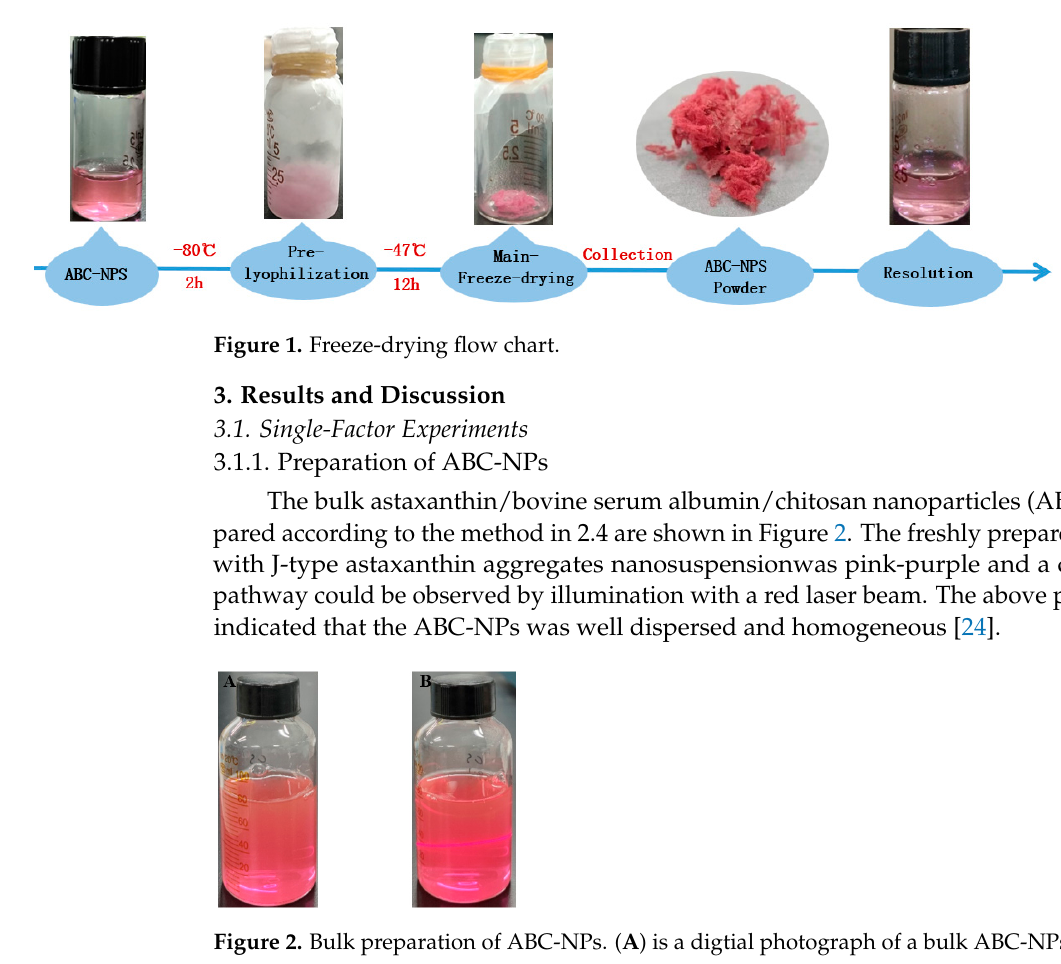
Figure 2. Bulk preparation of ABC-NPs. ( A ) is a digtial photograph of a bulk ABC-NPs nanosus- pension; ( B ) is a Tyndal phenomenon of ABC-NPs.